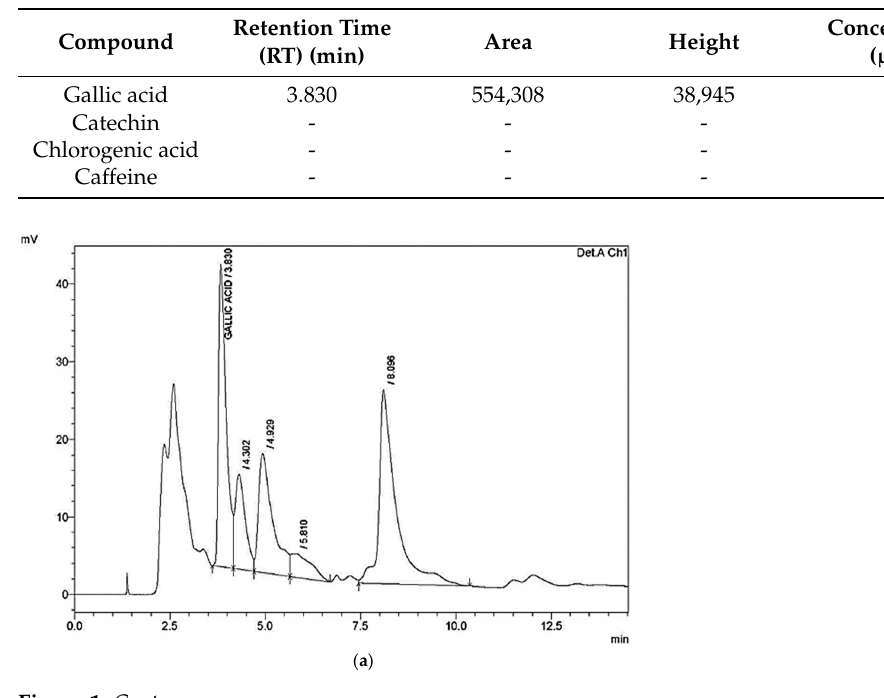
Table 2. Proximate composition of dried leaves of Rumex nervosus 1 .